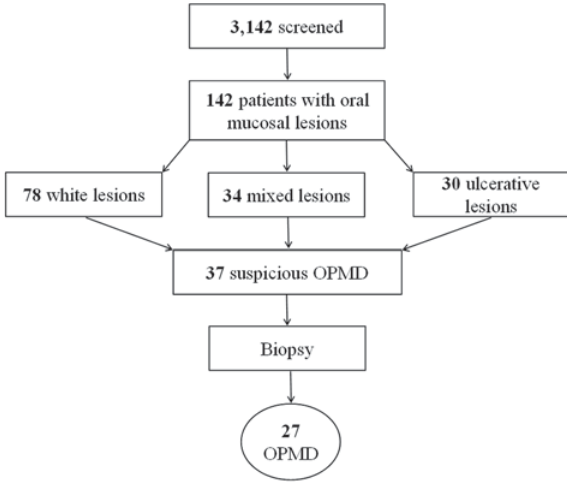
Figure 1- Oral mucosal lesions and oral